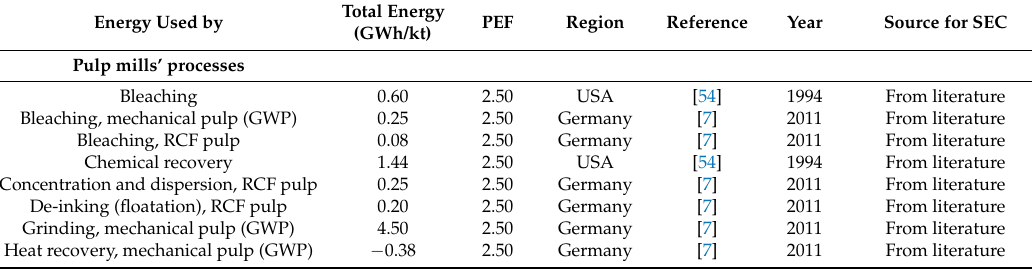
Table A2. Examples of SEC for various processes during pulp production, listed